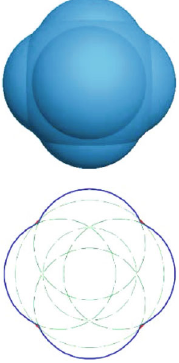
Figure 2: Particles and their pro fi